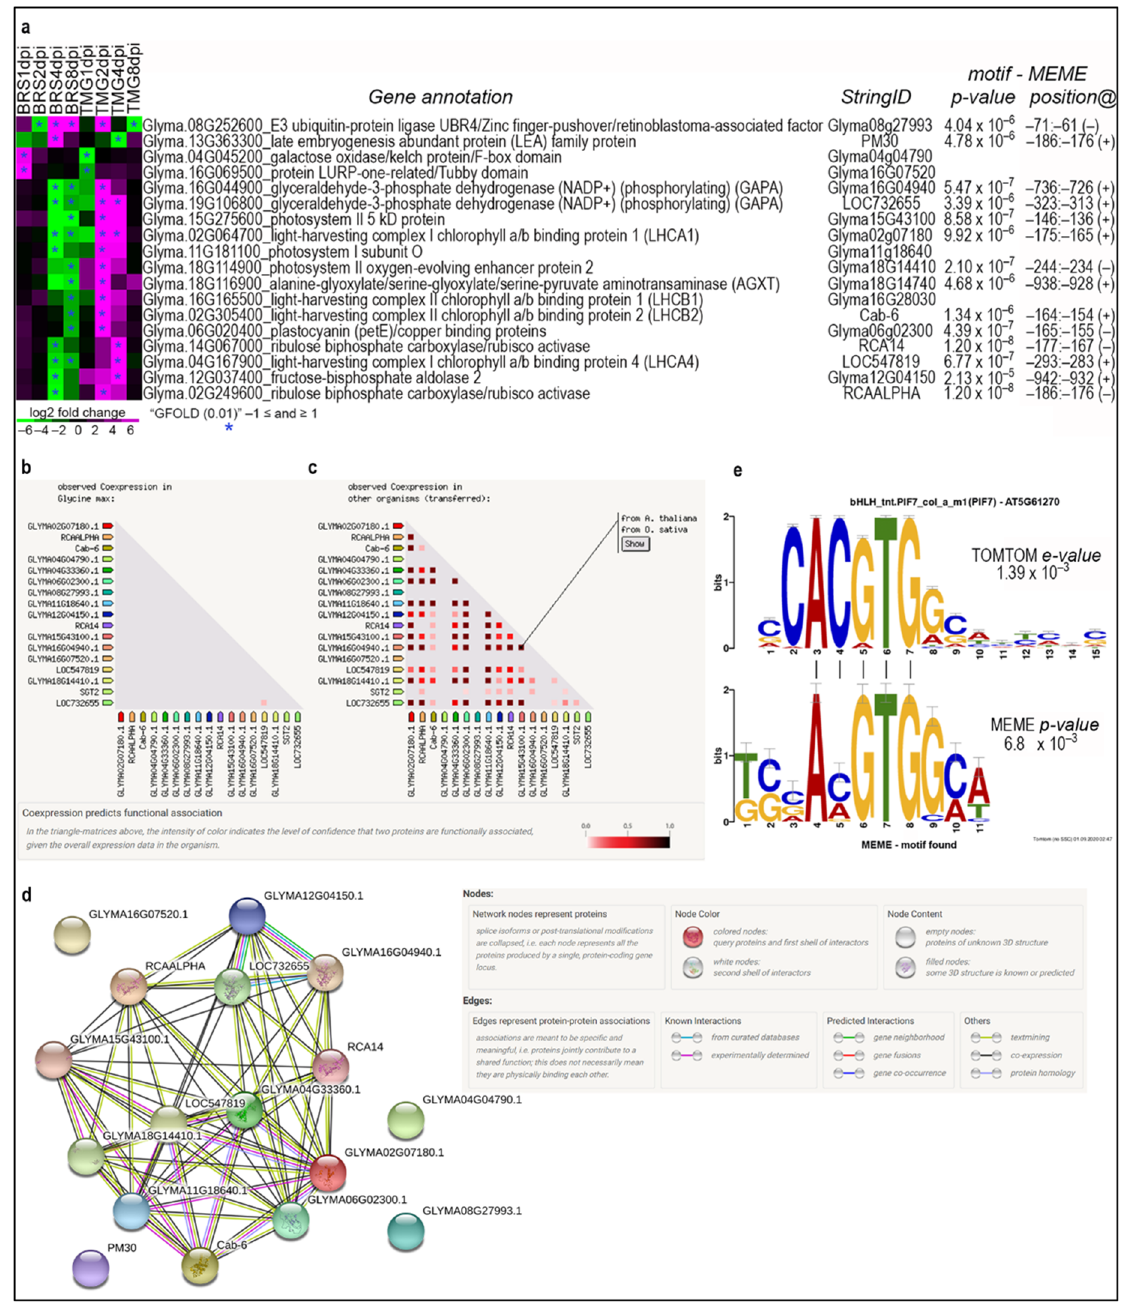
Figure 3. Co-expressed genes showing inverted profiles between genotypes. Heatmap showing the 18 DEGs identified as co-expressed with inverted profiles between genotypes ( a ). String co- expression data showing that these genes were not previously found as co-expressed in soybean ( b ). String co-expression data showing that these genes are highly co-regulated in other plant species ( c ). The expression network showing the predicted interaction of 13 of the 18 soybean genes showed significantly inverted expression profiles between genotypes, and genes interconnected with purple line means experimentally determined known interaction ( d ). Alignment of the promoter motif identified in these 18 genes by MEME with the motif of a plant non-canonical E-box cis element by TOMTOM ( e ). Figure 3a shows correspondence of current and former soybean gene model IDs in Figure 3b–d from the String